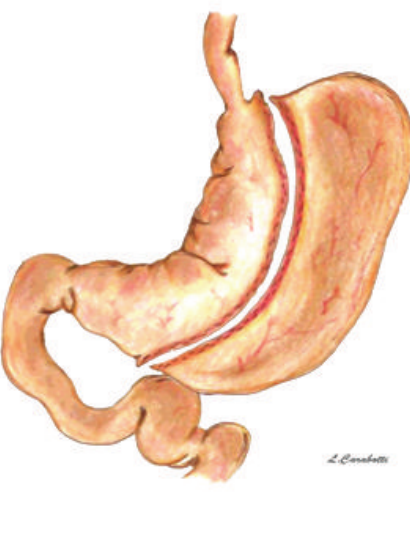
Figure 4: Sleeve